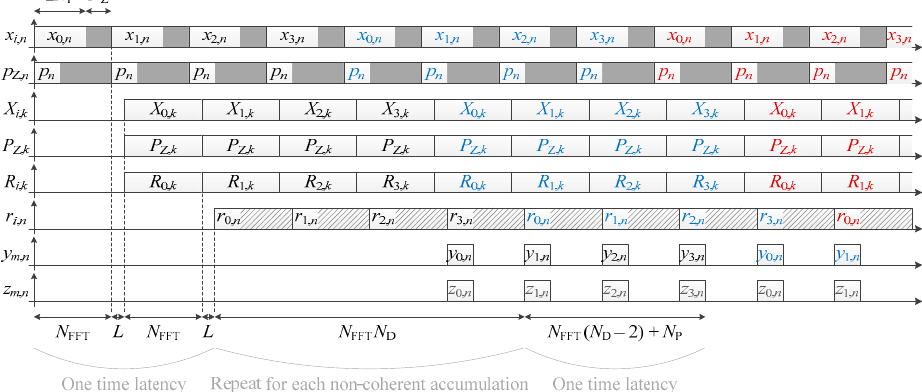
Figure 3. Timing diagram of a data channel acquisition shown in Figure 2, with N D = 4 for the illustration (in reality N D = 20 for the GPS L1 C/A signal). Colors indicate different portions corresponding to the length of one data bit. Grey color indicates intermediate results (i.e., the value is not yet the final one).